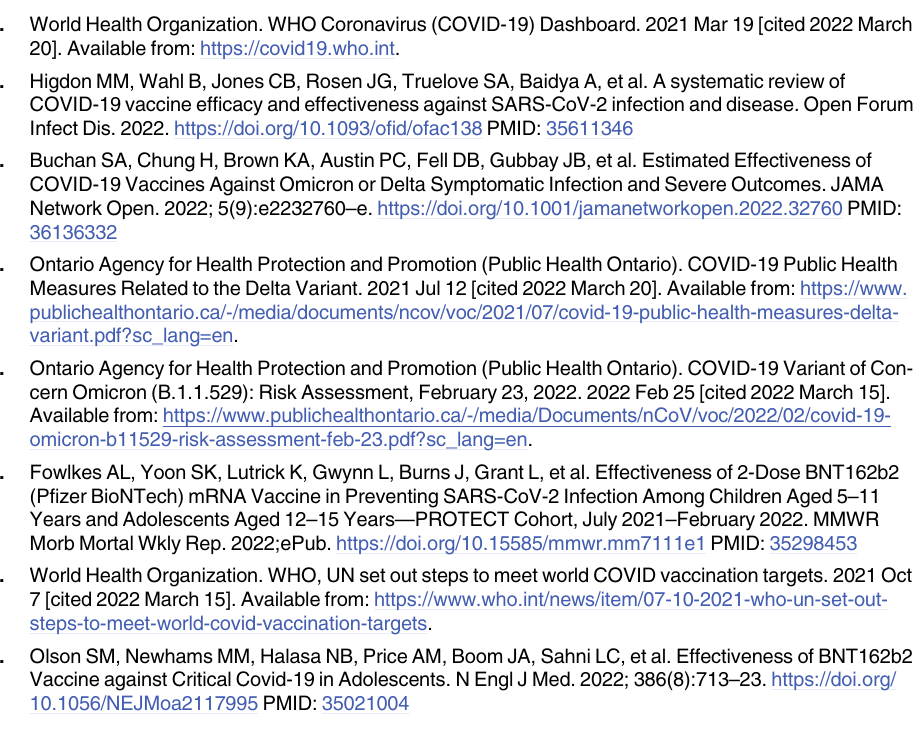
S2 Table. Adjusted odds ratios of the association between vaccination status and hospitali- zation among adolescent and pediatric SARS-CoV-2 cases with varying